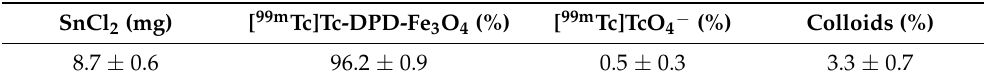
Table 4. Effect of the amount (mg) of SnCl 2 on the radiolabeling yield (%) [ 99m Tc]Tc-DPD-Fe 3 O 4 DMCA, incubated at pH 7 for 60 min at RT. The respective % of free [ 99m Tc]TcO 4 − and colloidal 99m Tc are also indicated. The results are expressed as mean value ± standard deviation of independent